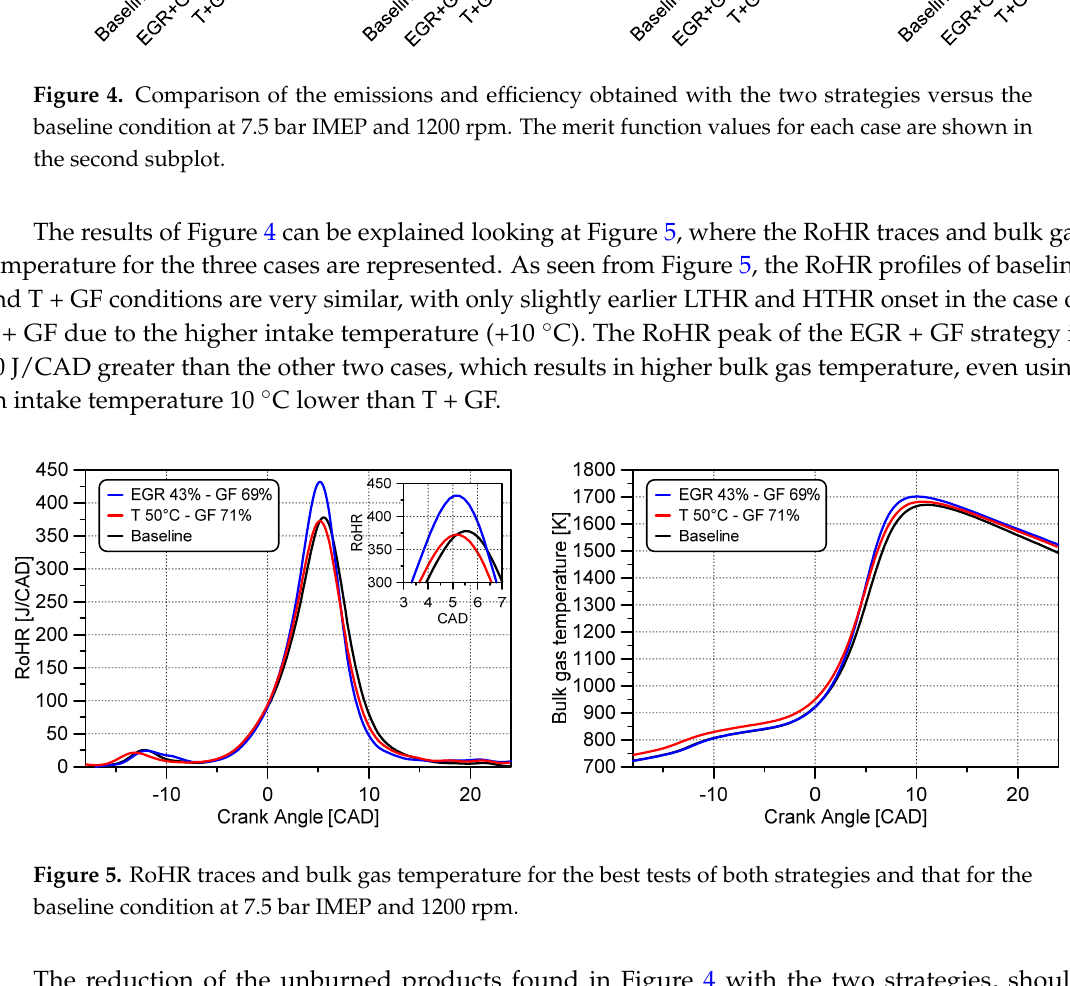
Figure 4. Comparison of the emissions and efficiency obtained with the two strategies versus the baseline condition at 7.5 bar IMEP and 1200 rpm. The merit function values for each case are shown in the second subplot.